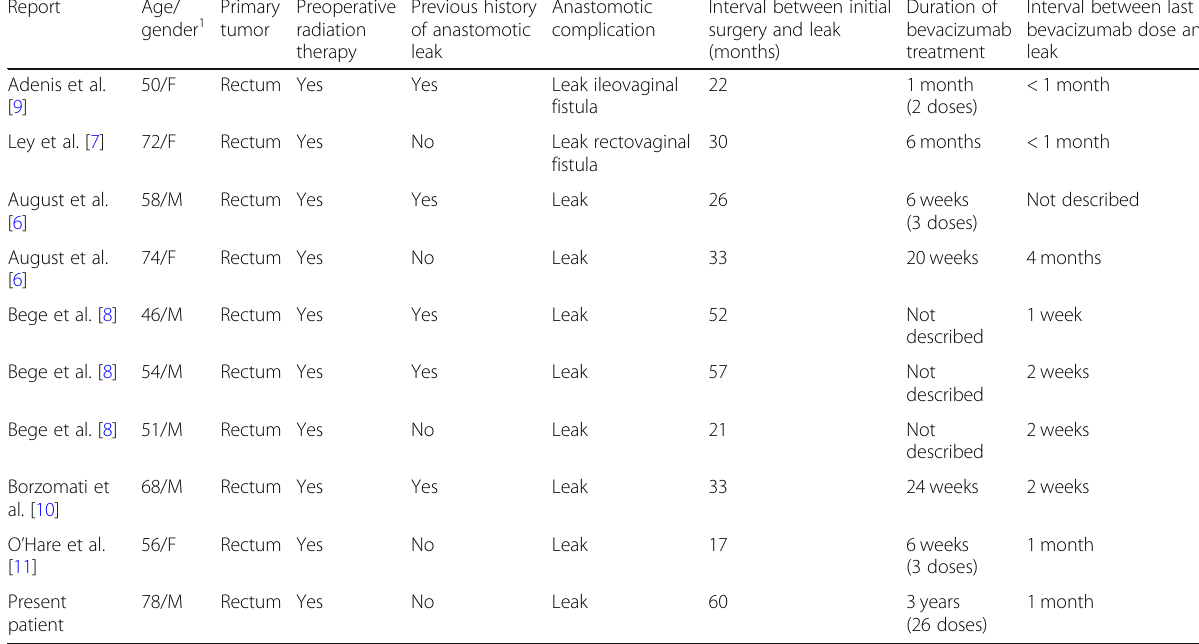
Table 1 Clinical features of ten patients with delayed anastomotic leak associated with bevacizumab treatment Report